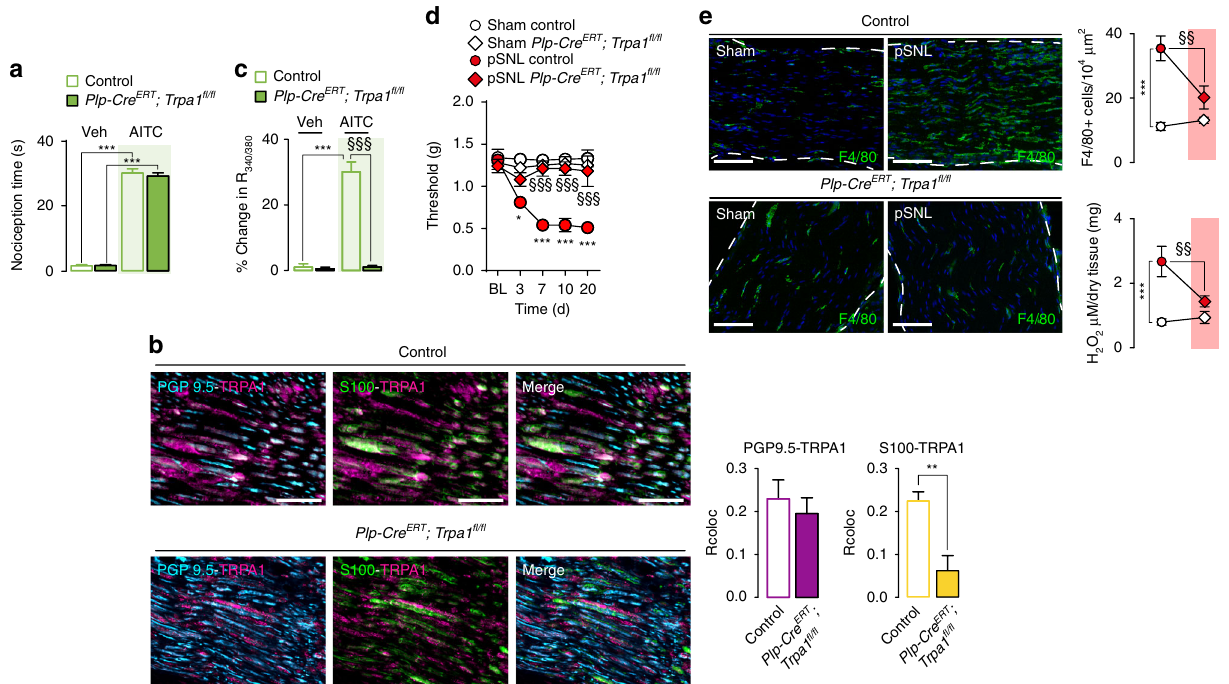
Fig. 8 Plp1-Cre/ERT – mediated Trpa1 deletion from Schwann cells prevented the partial sciatic nerve ligation (pSNL)-evoked allodynia and neuroin fl ammation. a Acute nociception response induced by intraplantar AITC (10 nmol 20 µ l − 1 ) or vehicle (veh, 0.5% DMSO) in Plp1-Cre ERT ;Trpa1 fl / fl and control mice ( n = 6, *** P < 0.001 AITC vs. veh; one-way ANOVA followed by Bonferroni post hoc analyses). b Triple immuno fl uorescence staining